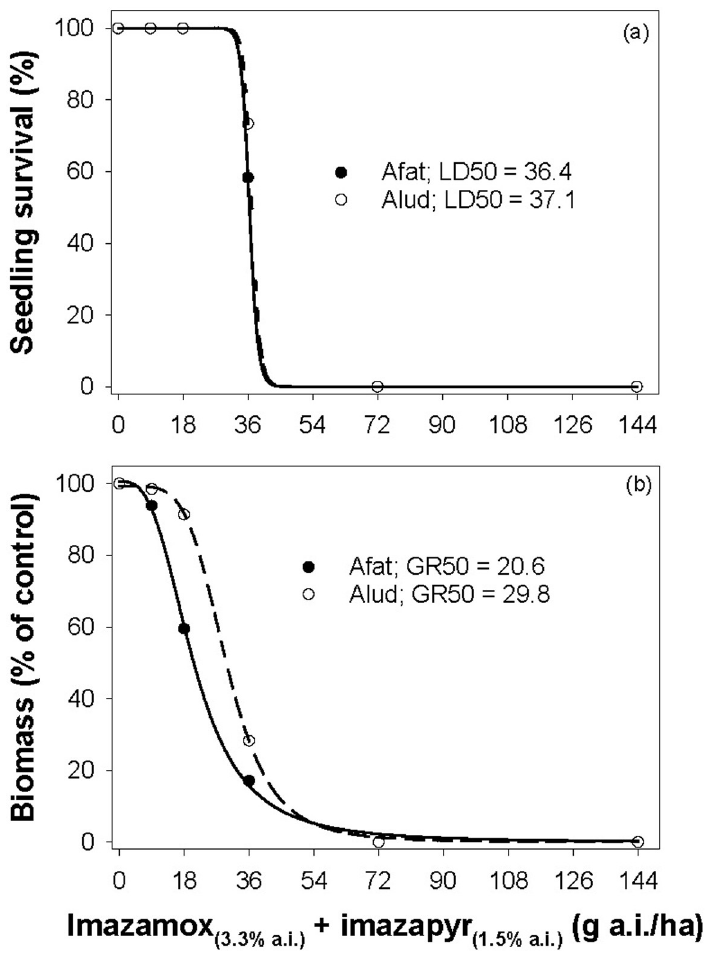
Fig 2. Effect of imazamox and imazapyr (a commercial mixture) dose on survival (%) (a) and biomass (percent of nontreated control) (b) of the glyphosate-resistant biotypes of Avena fatua (Afat) and A . ludoviciana (Alud). Plants were sprayed at the 4–5 leaf stage of each